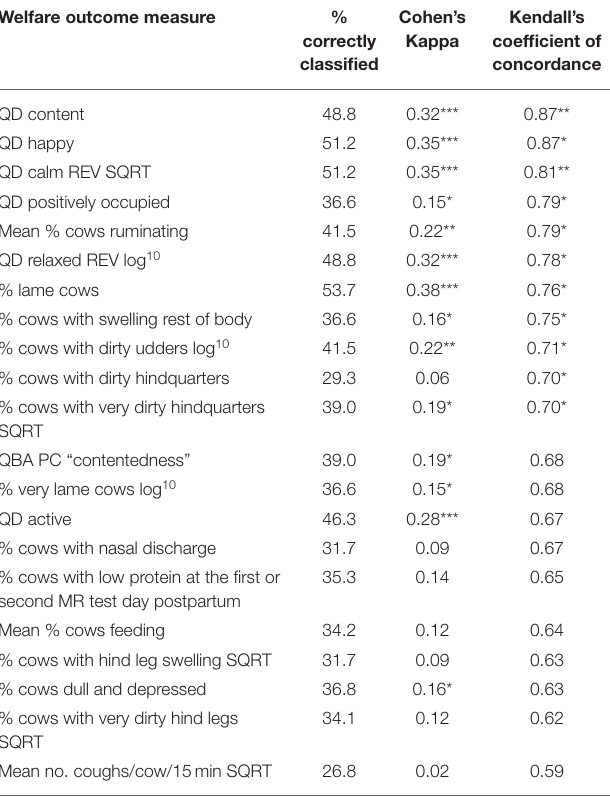
TABLE 5 | The relative performance of welfare outcome measures in predicting their respective composite welfare categories. Welfare outcome